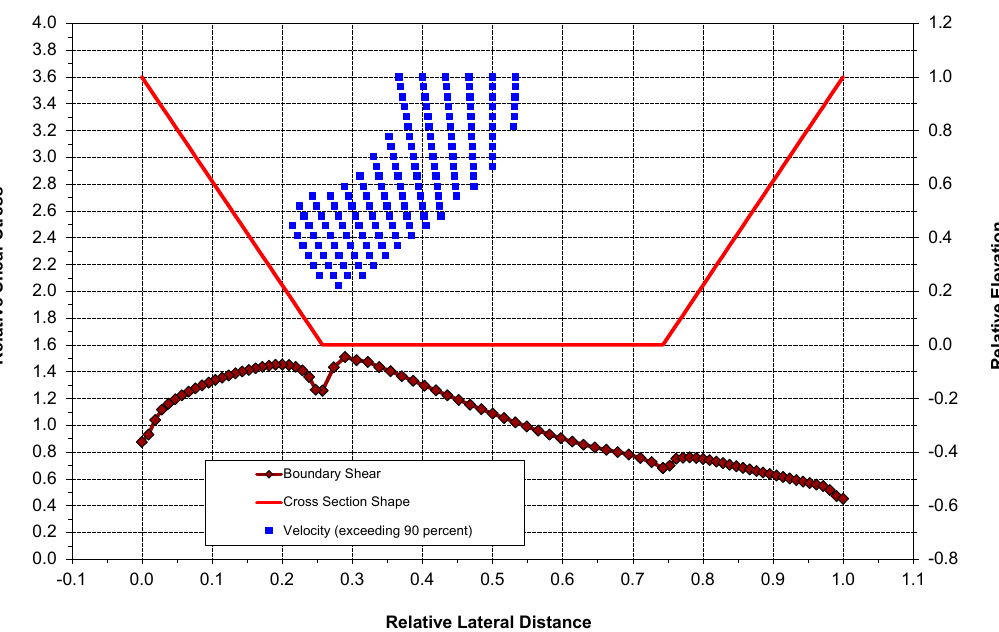
Figure 22. Example of simulated shear stress, and region of highest velocity, at a cross section from the fourth meander bends of Simulation Set 4 with a sinuosity of 2.00. A mesh size of 1142 × 31 × 28 (991,256 mesh cells) was used in the simulation.